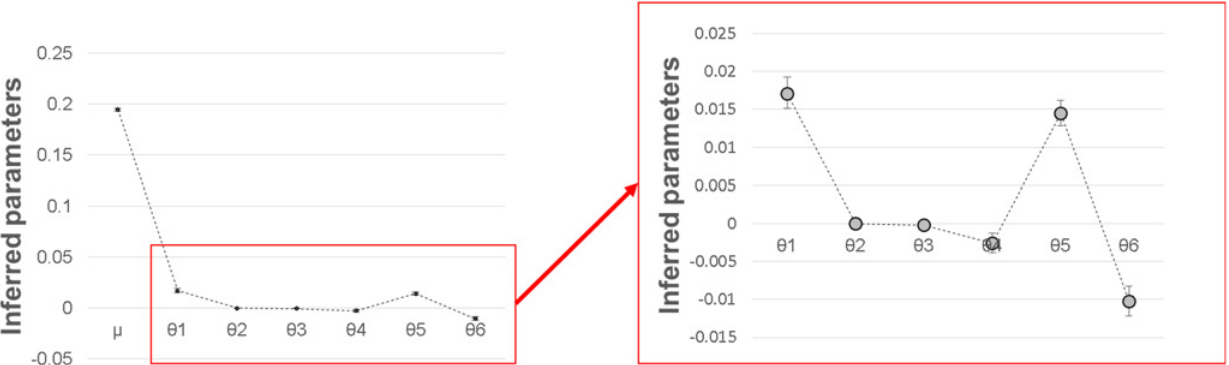
Fig 4. Results of the landscape-scale Bayesian model (values are provided in Table 3). Points show the inferred parameters with their 95% posterior probability: μ is the global mean, θ 1 represents the effect of site, θ 2 is the slope of the relation between the geographical and genetic distance within sites in a two-dimensional x,y-plane, θ 3 is the slope of the relation between the geographical and genetic distance within sites according to an elevation gradient, θ 4 describes the effect of drought severity, θ 5 describes the effect of waterlogging frequency and θ 6 describes the effect of soil